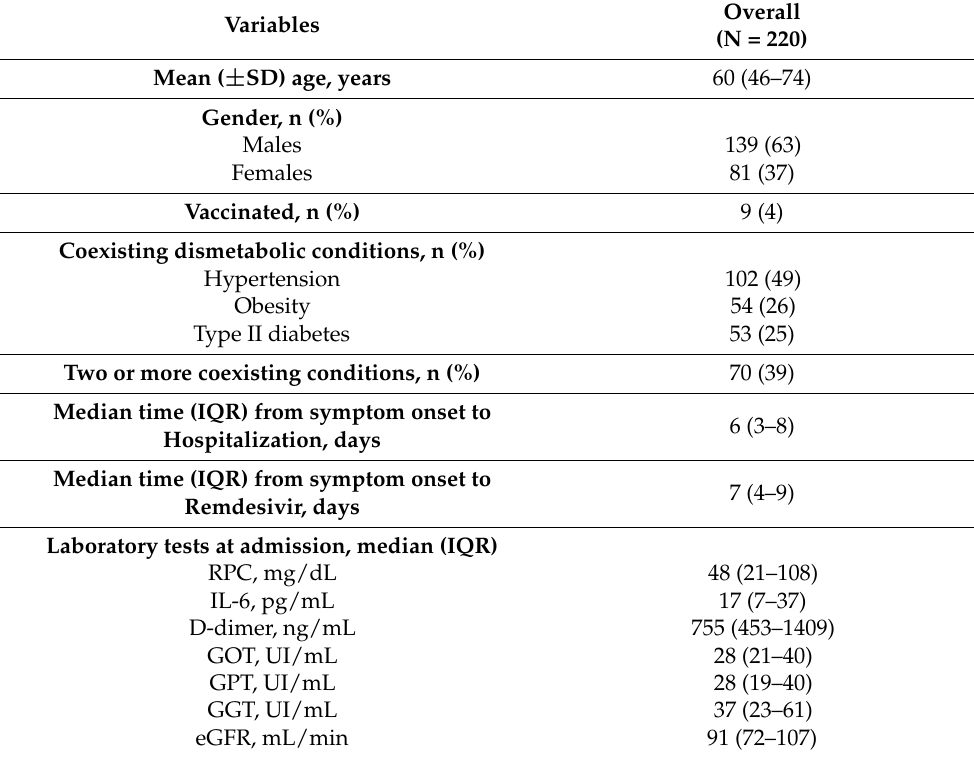
Table 1. General features of all patients treated with